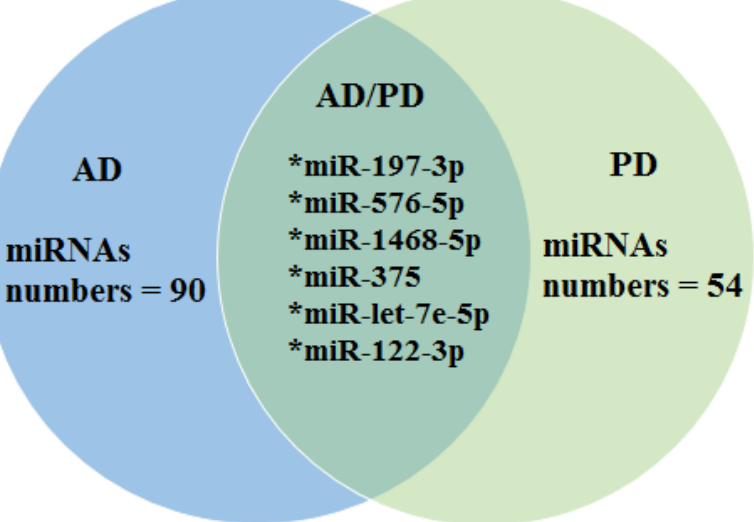
Figure 2. Number and types of miRNAs found at the intersection between Alzheimer’s disease (AD) and Parkinson’s disease (PD). * Common microRNAs in AD and PD (intersection). Through the Forest Plot graph presented in Tables 5 and 6 relating to AD, the values distribution of each study’s means and the standard deviation of accuracy (%) concerned the total mean of 84.37 ± 7.94%, in the confidence interval of 95%. Through this, eight studies were identified with accuracy values (%) equal to or above the total average. These eight studies are identified by reference numbers [2–5,8,11,12,14]. These eight studies were selected to determine their respective types of miRNAs. Table 5. Results of the statistical analysis of the accuracy (%) of identification and quantification by qPCR of miRNAs concerning Alzheimer’s disease (AD), with p > 0.05 and no statistically significant difference, at 95% CI.